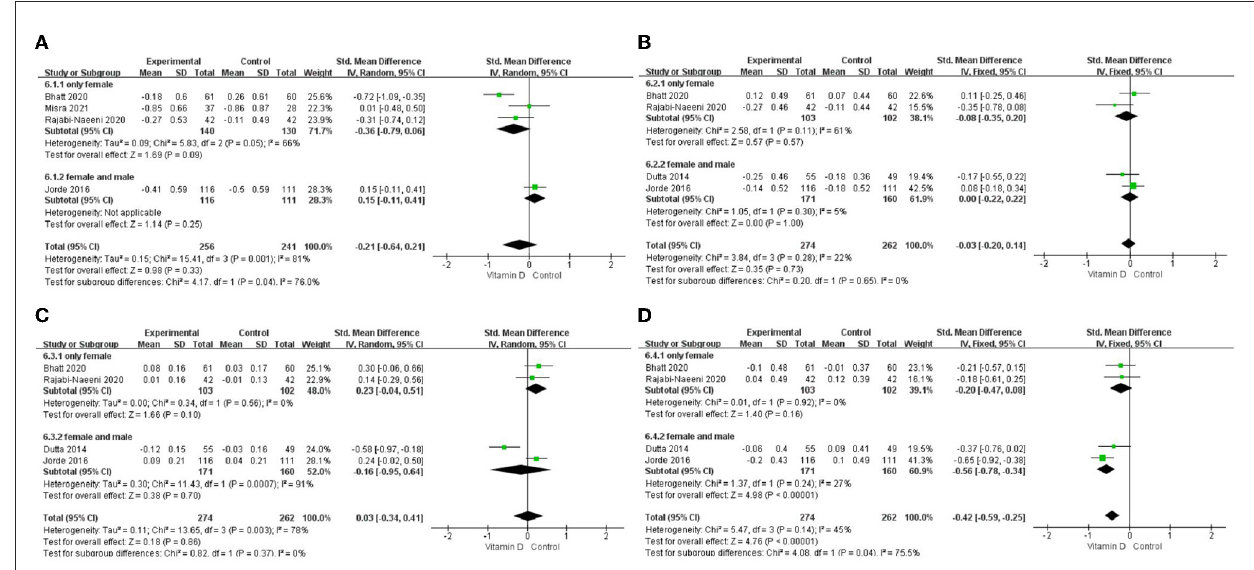
FIGURE8 Subgroup analysis by sex. (A) TC, (B) LDL-C, (C) , HDL-C, and (D) TG. TC, total cholesterol; LDL-C, low-density lipoprotein cholesterol; HDL-C, high-density lipoprotein cholesterol; TG, triglyceride.